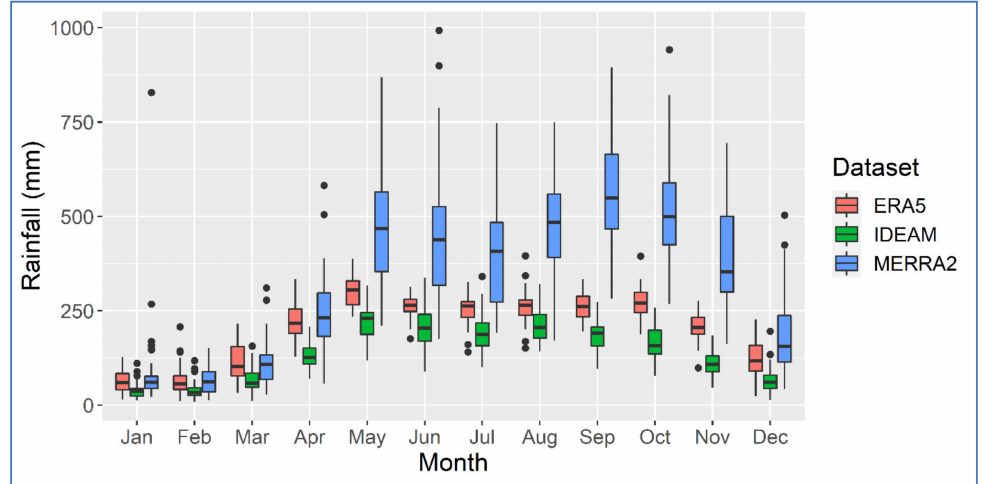
Figure 6. Average monthly rainfall in the Middle Sin ú River basin based on the three datasets for 1985–2019. In this boxplot, the extremes of the box are the first (Q1) and third (Q3) quartiles; the bar indicates the median; the whiskers correspond to Q1—1.5 IQR and Q3 + 1.5 IQR. The points are potential